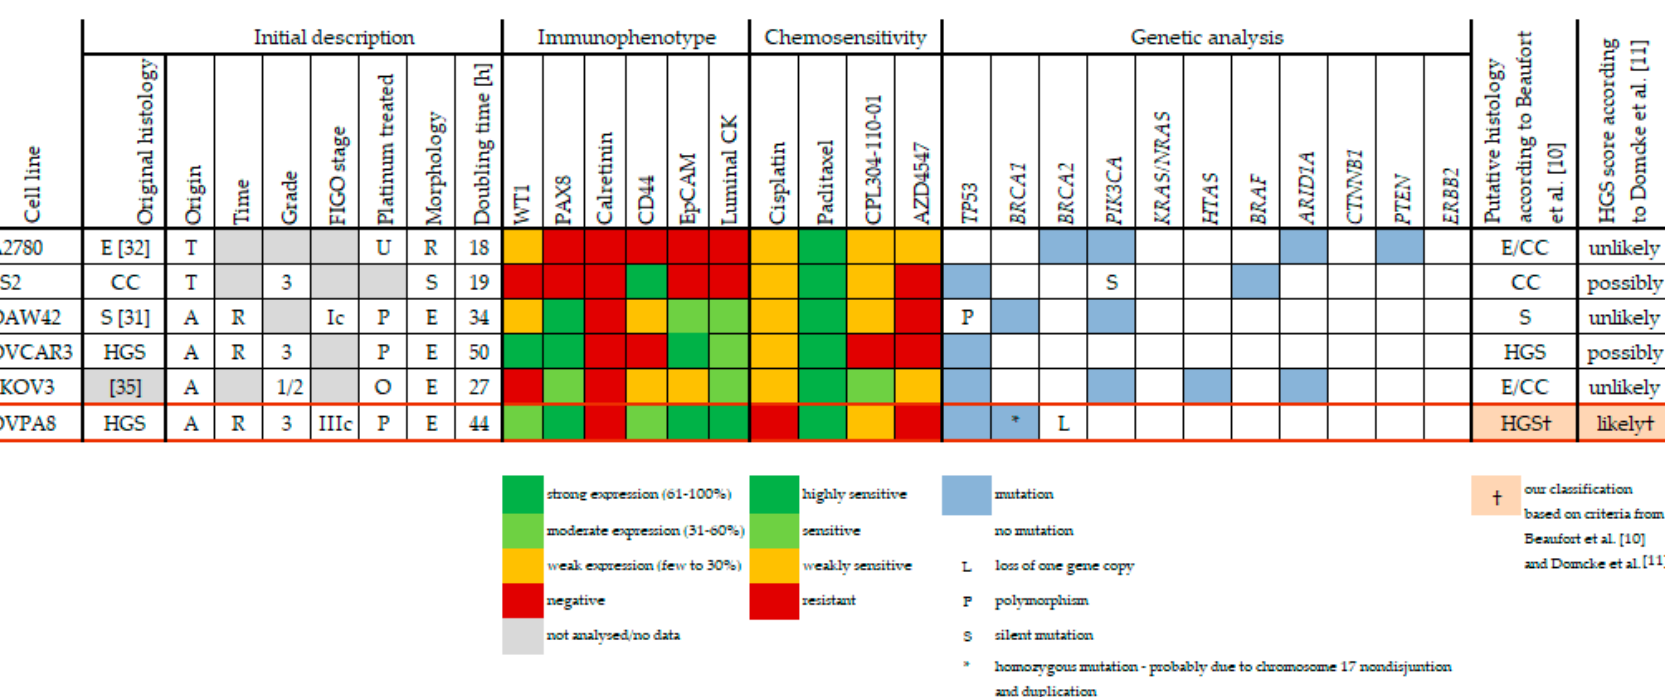
Figure 14. Summary of the OVPA8 cell line characteristics in comparison to five commercially available ovarian cancer cell lines. Original histology: CC—clear cell, E— endometrioid, HGS—high-grade serous, S—serous; Origin: A—ascitic fluid, T—tumor; Time: R—relapsed disease; Platinum treatment: U—untreated, P—platinum-based chemotherapy, O—other chemotherapy; Morphology: E—epithelial, R—round, S—spindle. Genetic data for commercially available cell lines were taken from [10] (except for TP53 and BRCA genes).